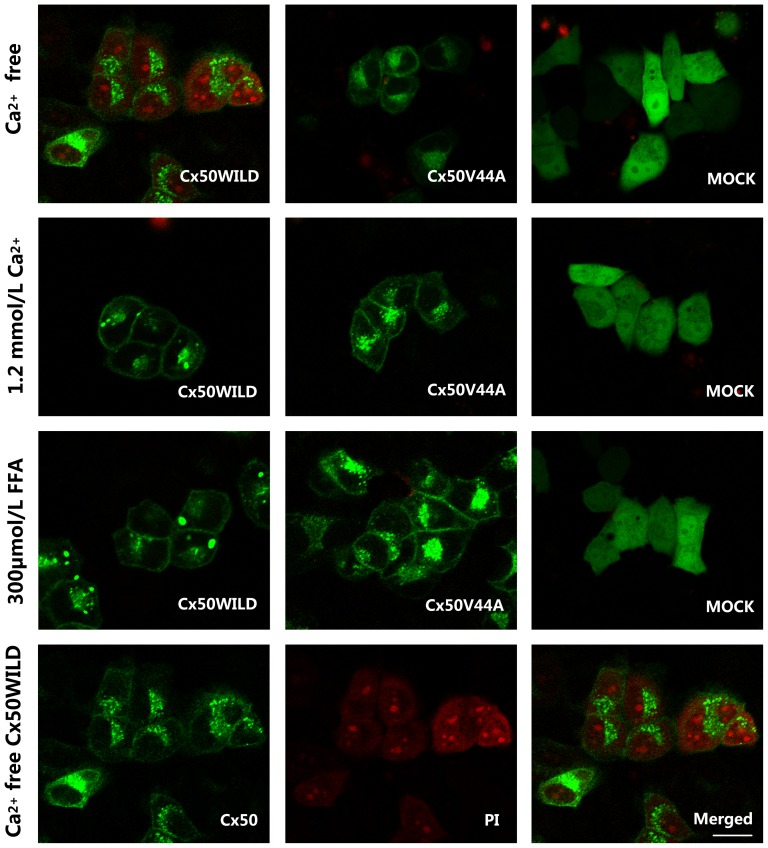
Statistical analysis of DAPI (A) and PI (B) loading in different solutions.Data are presented as mean±SDs. There was a significant difference in the percentage of dye-stained cells between the Cx50WILD and Cx50V44A groups in the Ca2+-free environment (P<0.001, marked with ***); there was also a significant difference between the Ca2+-free Cx50WILD and the 1.2 mM Ca2+/300 µM FFA Cx50WILD group (P<0.001, marked with ***).